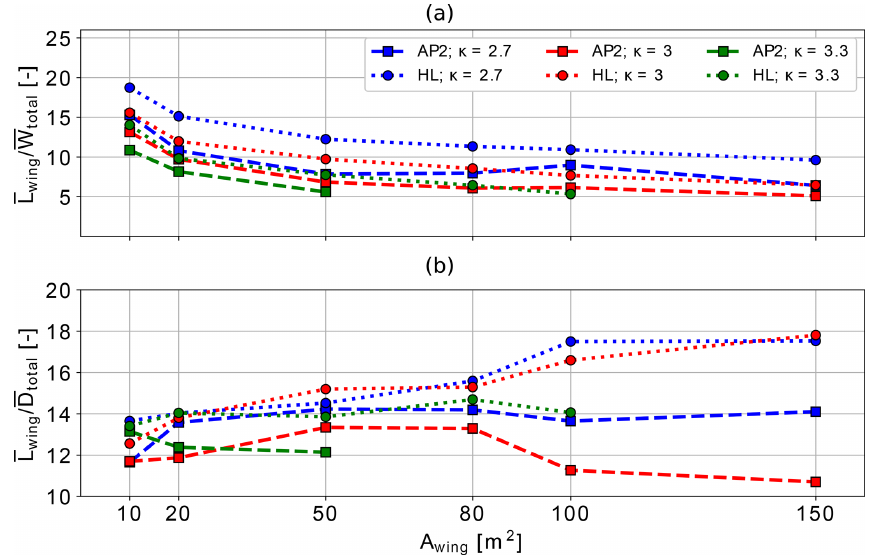
Figure 14. Load factor or lift L wing to W total ratio (a) and cycle average total lift L wing to drag D total , including tether drag, (b) during production phase (reel-out) for all aircraft sizes A = 10–150m 2 , sets of aerodynamic coefficients AP2, HL and mass scaling exponents κ = 2 . 7, 3, 3.3 for wind data at the offshore location. Large-scale results for A = 100, 150m 2 might be misleading because only high wind speeds result in feasible solutions (compare Fig. 15).